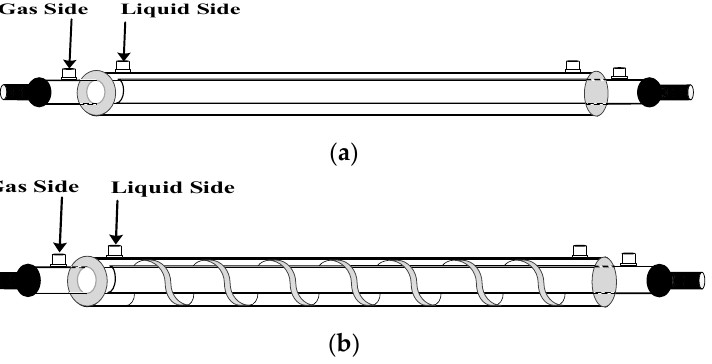
Figure 1. Empty and spiral wired annulus channels of concentric circular membrane contactors. ( a ) Empty channel; ( b ) Spiral wired channel.